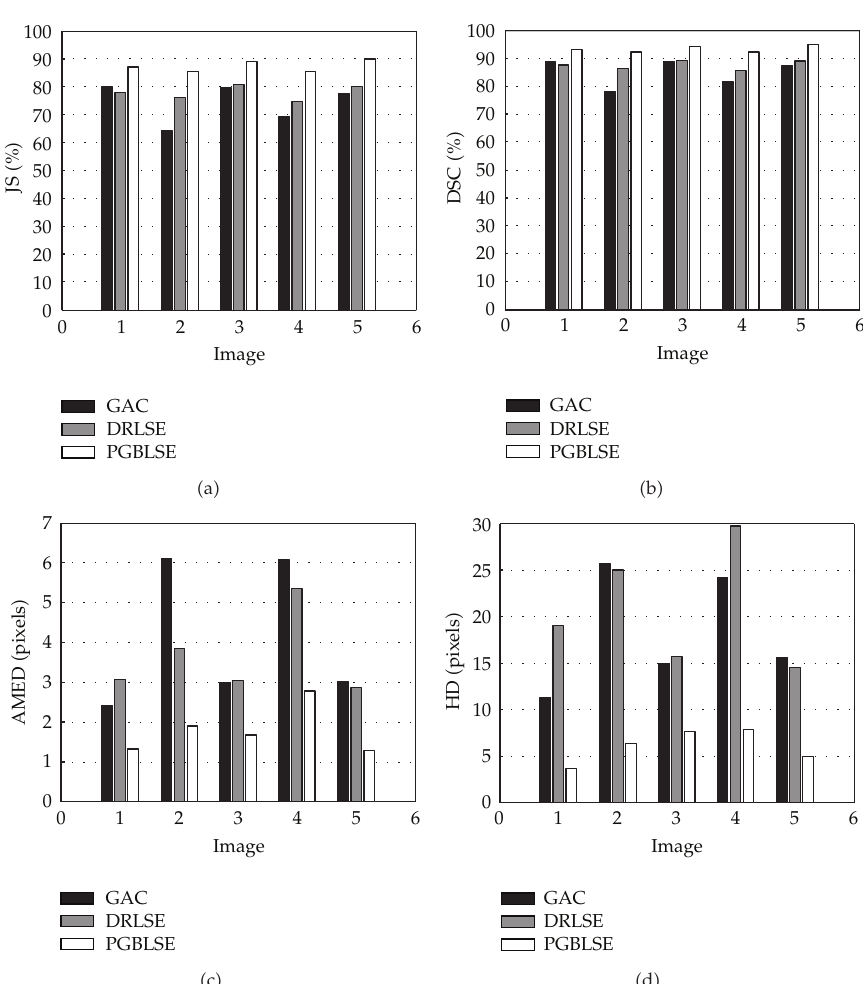
Figure 11: Bar plots of segmentation errors among the GAC, DRLSE, and PGBLSE models. (cid:3) a (cid:4) JS error. (cid:3) b (cid:4) DSC error. (cid:3) c (cid:4) AMES error. (cid:3) d (cid:4) HD error. The x -axis represents five images in Figures 6 (cid:3) a (cid:4) –10 (cid:3) a (cid:4) in the same